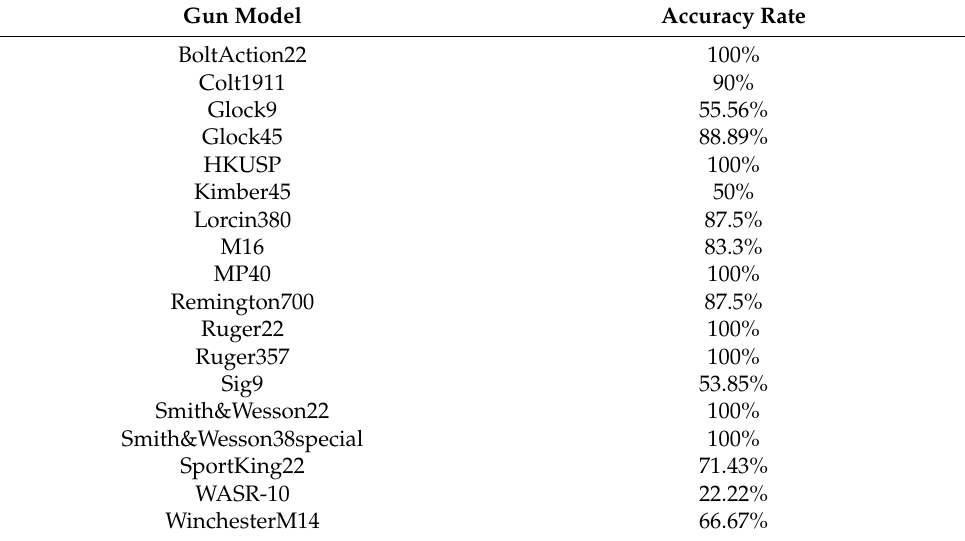
Table 3. Classified recognition of 18 kinds of